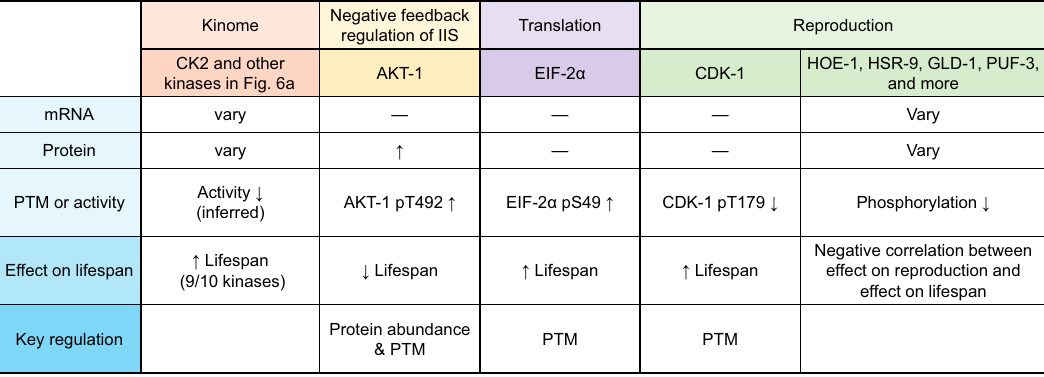
Fig. 7 Phosphoproteomics analysis supports concerted regulation of longevity from multiple pathways upon reduced IIS. daf-2(lf) induced extensive phosphorylation changes on components of the IIS pathway, translational machinery, reproductive system, and kinome. Phosphorylation changes at AKT-1 pT492, EIF-2 α pS49, and CDK-1 pT179 all affect lifespan, while their parent proteins and the encoding mRNAs show no or little change in the daf-2 mutant, except for AKT-1. The proteins involved in reproduction and lifespan determination are likely regulated through phosphorylation by IIS, since no clear pattern of changes is evident based on analysis of their mRNA or protein levels. Similarly, reduction in IIS may lower the activity of pro-ageing kinases, and